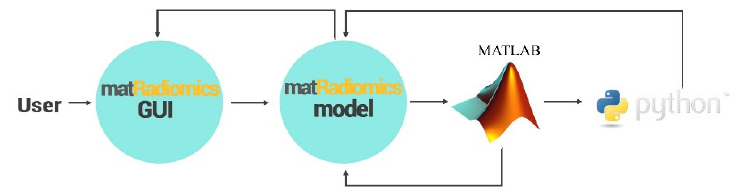
Figure 1. matRadiomics Architecture.